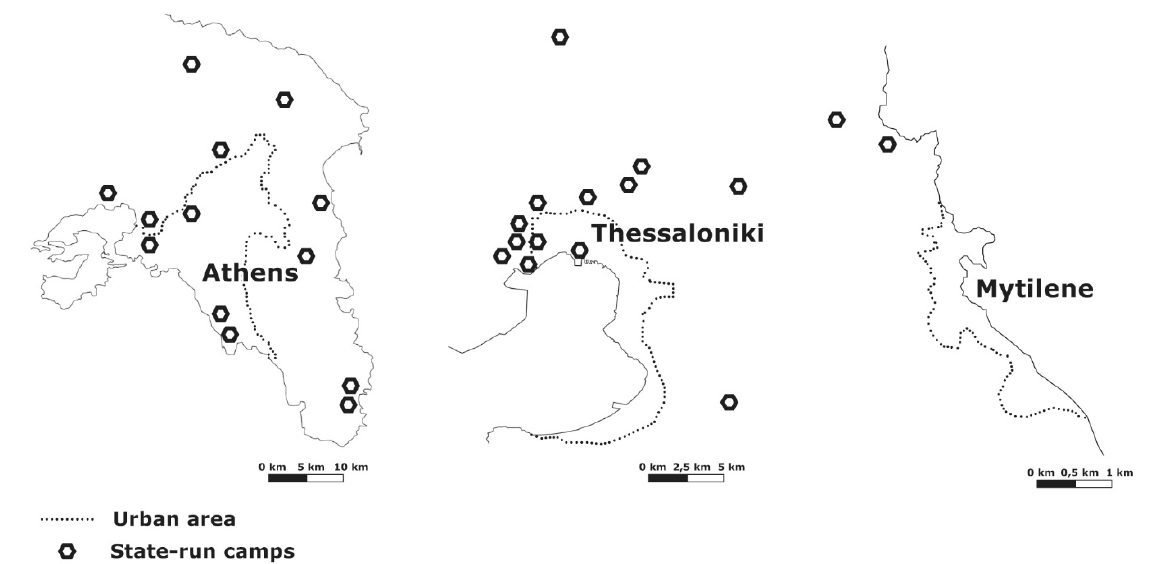
Figure 1. State-run refugee camps in Athens, Thessaloniki, and Mytilene, 2016–2017. Source: